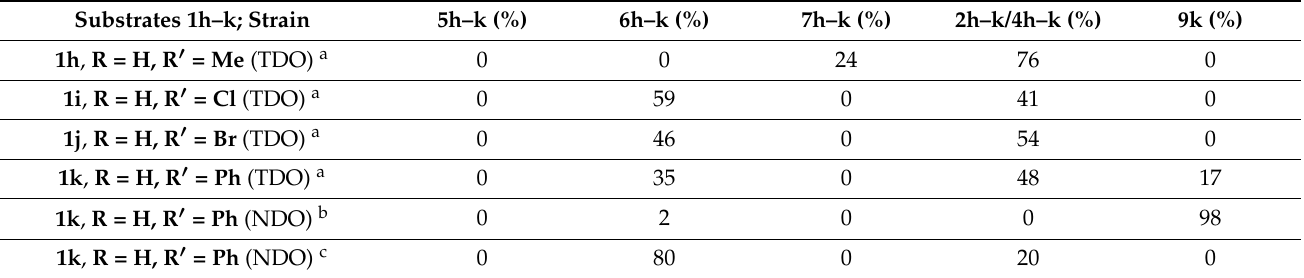
Table 2. Relative yields of metabolites from 3-substituted thiophenes 1h-k [12]. Substrates 1h-k; Strain